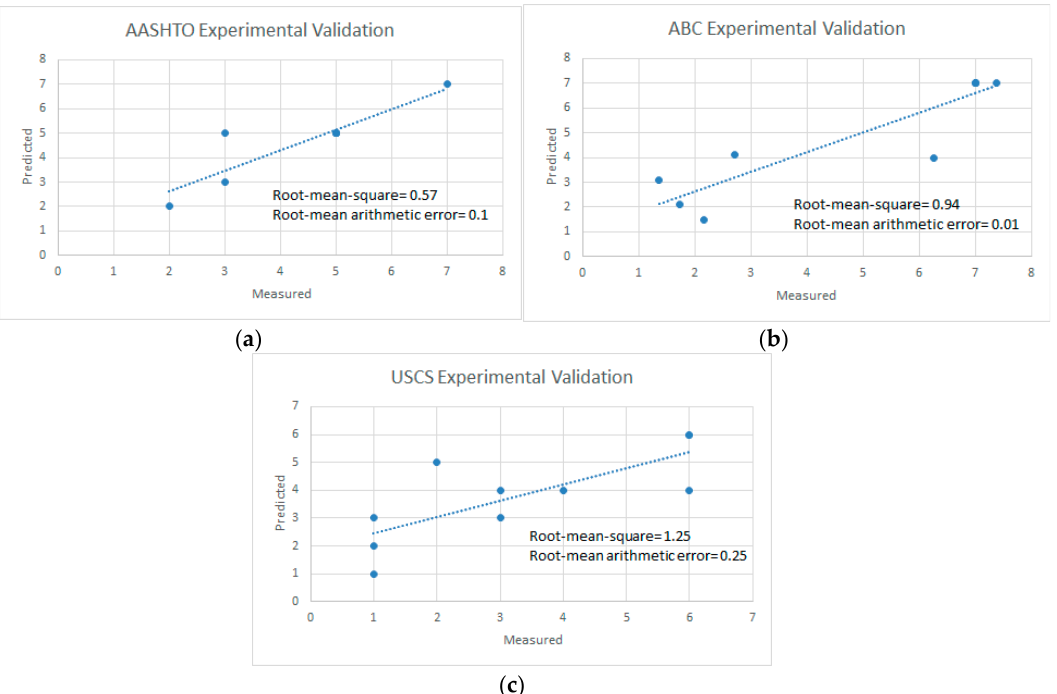
Figure 10. ( a ) Validation of AASHTO Map Using Unseen Data; ( b ) Validation of Allowable Bearing Capacity Map Using Unseen Data; ( c ) Validation of Engineering Classification of Soil Map Using Unseen Data.